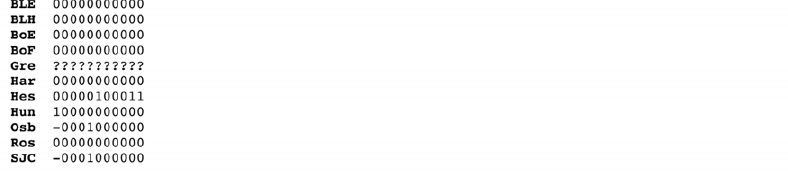
Figure 2. Phylogenetic analysis of texts.